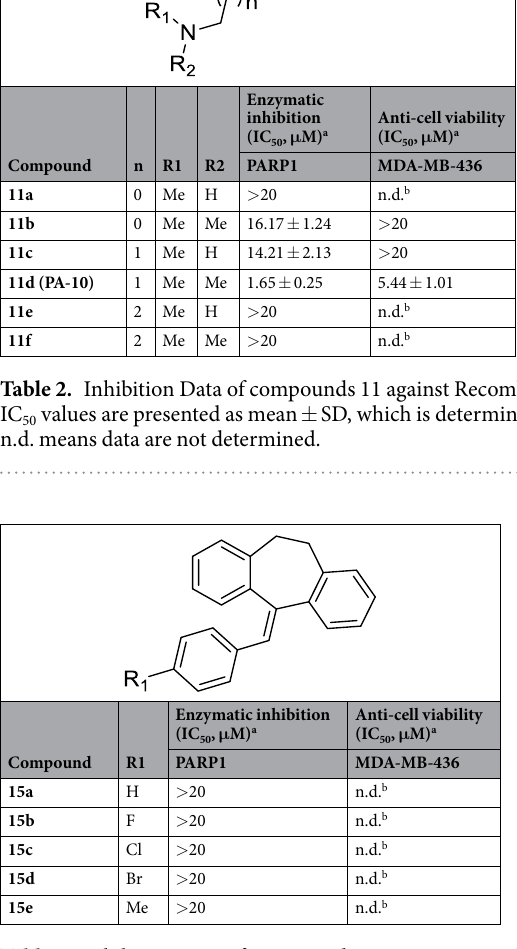
Table 3. Inhibition Data of compounds 15 against Recombinant Human PARP1 and MDA-MB-436 cells. a The IC 50 values are presented as mean ± SD, which is determined by at least three independent experiments. b The n.d. means data are not